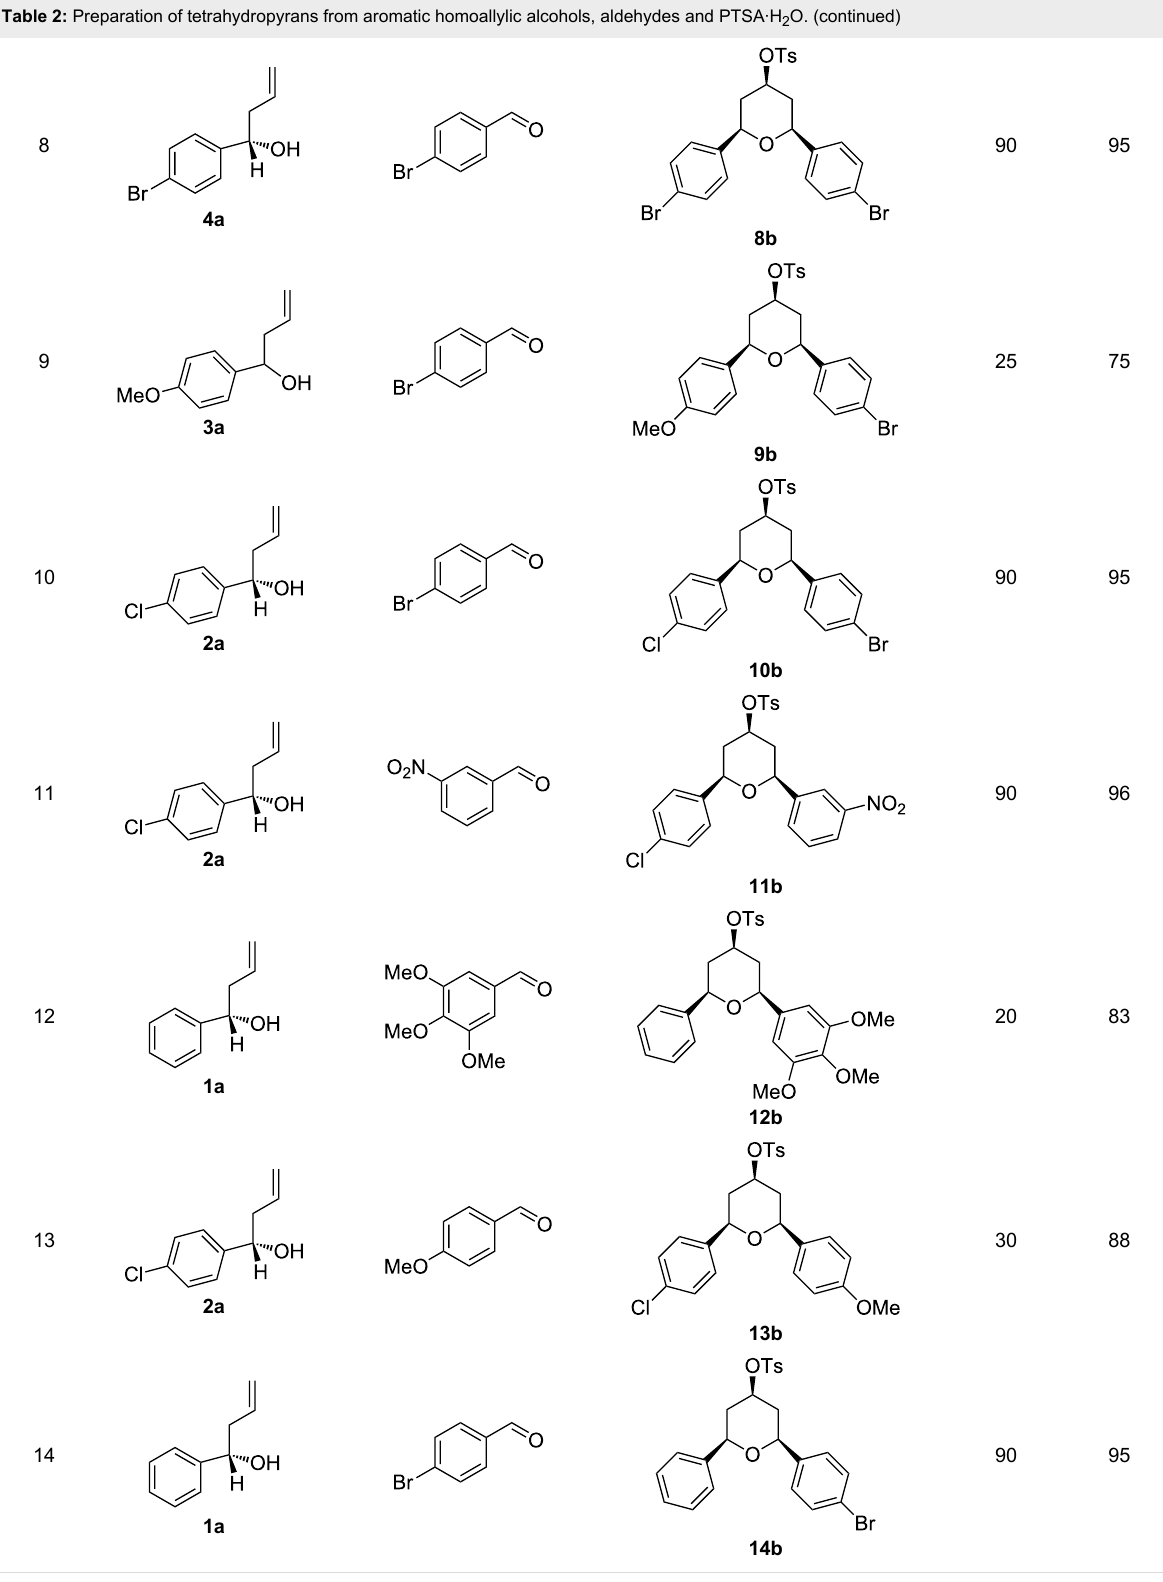
Table 2: Preparation of tetrahydropyrans from aromatic homoallylic alcohols, aldehydes and PTSA·H 2 O. (continued)